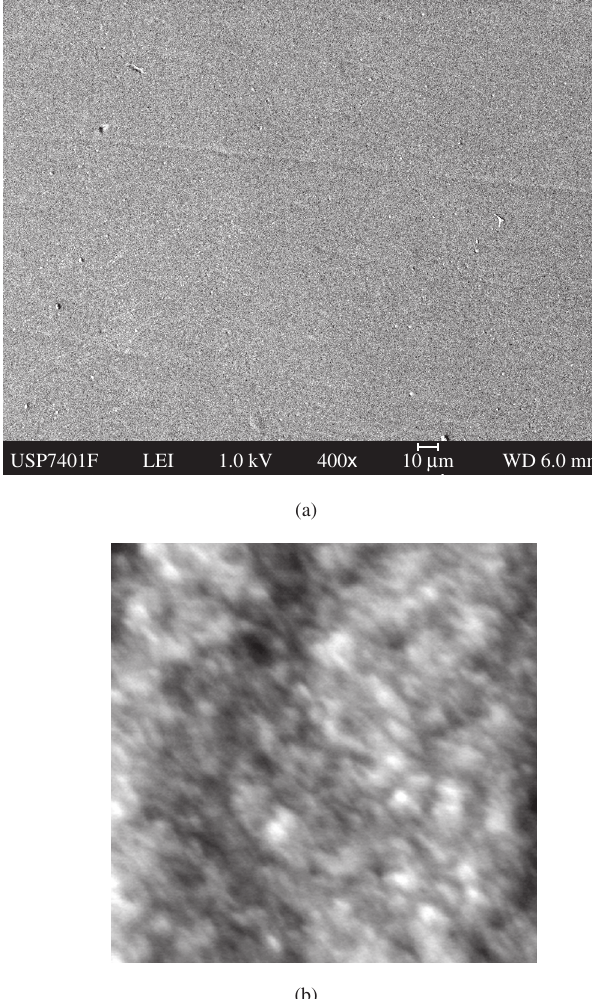
Figure 5. Adsorption isotherms obtained for LYZ onto CAP coated Ti in water (open square), NaCl 0.1 mol.L –1 (open circle) and 0.2 mol.L –1 (solid triangle) at 25 °C.